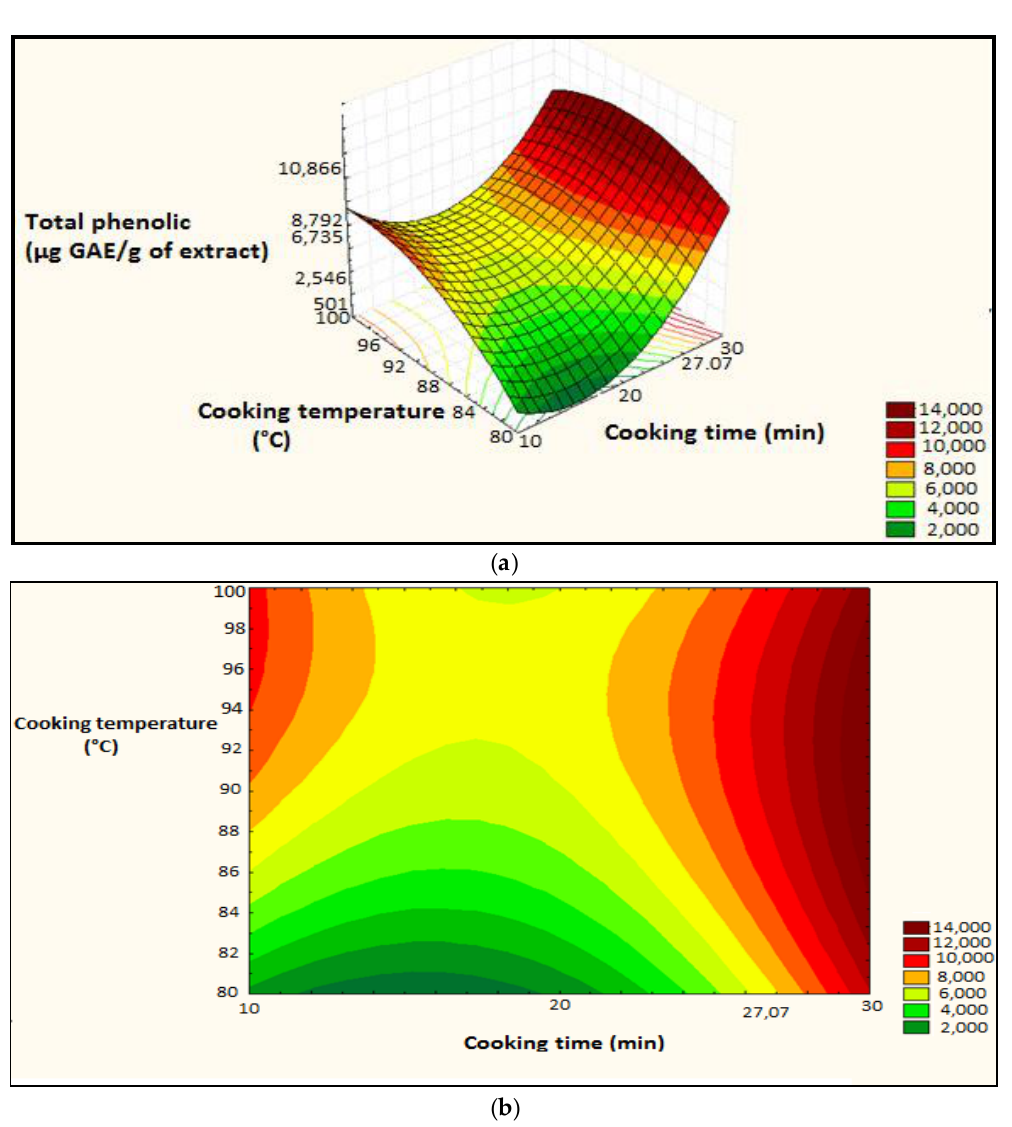
Figure 7. Surface plot and iso-response curve of polyphenols as a function of the two factors cooking time and temperature, ( a ): surface plot; ( b ): iso-response curve.